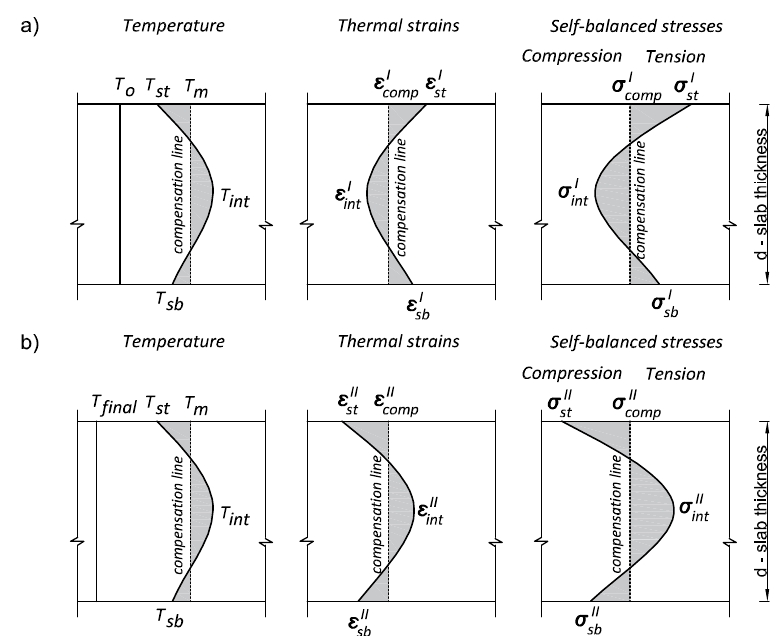
Figure 3. The idea of the compensation plane method – distribution of temperature, thermal strains and stresses at the thickness of the slab: ( a ) Heating phase, ( b ) cooling phase [9]. The recommended values of the coefficient of thermal expansion α (cid:2904) for a different type of aggregate in concrete are taken from [1] and listed in Table 7. Table 7. The coefficient of thermal expansion of concrete [1] .